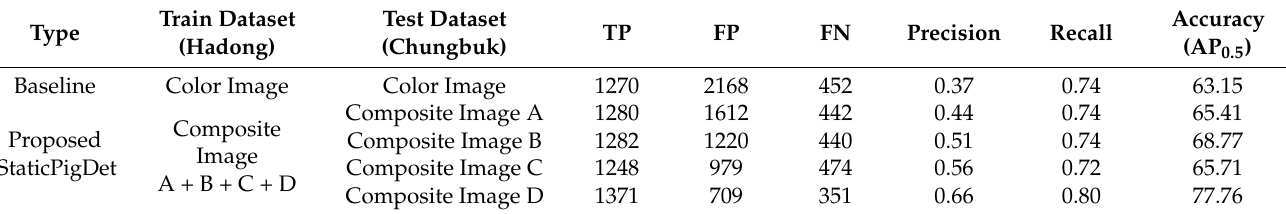
Table 7. Detection accuracy results for Chungbuk dataset with tinyYOLOv7 [42].